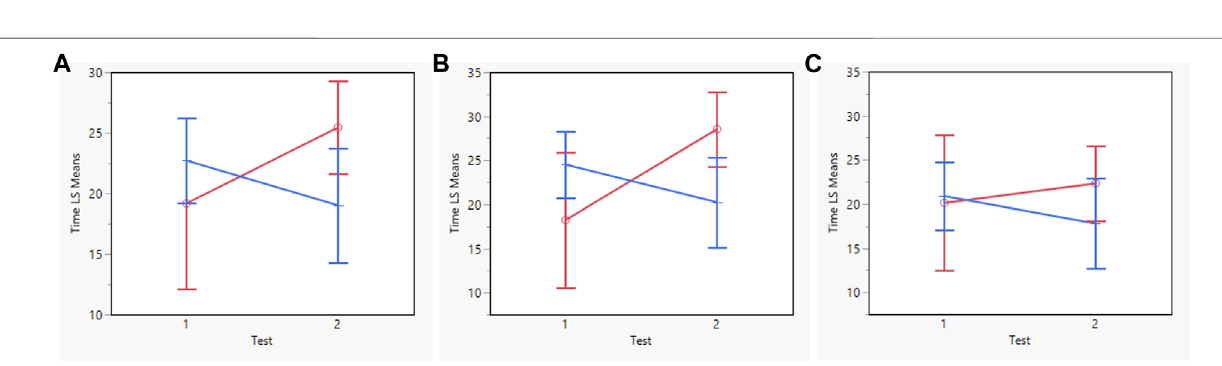
Frontiers in Virtual Reality |